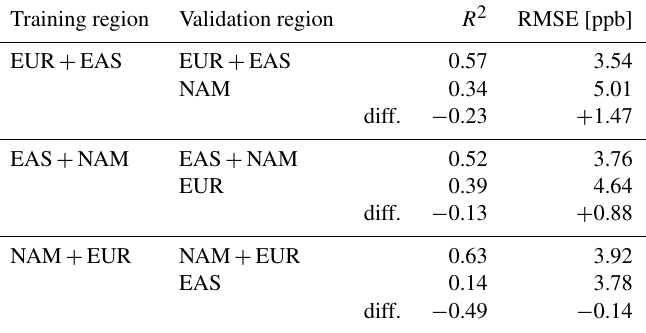
Table 5. Cross validation on the world regions Europe (EUR), East Asia (EAS), and North America (NAM). We give the difference in R 2 values and RMSEs when validating the model in another world region than the training